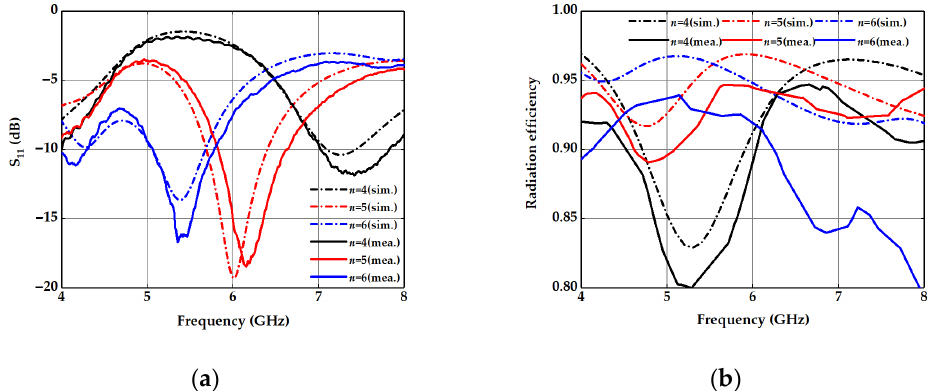
Figure 5. ( a ) Simulated and measured S 11 of spoof plasmonic dipole antennas ( n = 4, 5 and 6). ( b ) Simulated and measured radiation efficiency of spoof plasmonic dipole antennas ( n = 4, 5 and 6).